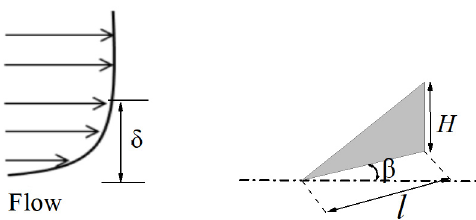
Figure 3. Diagram of VG height ( H ) and boundary layer thickness ( δ ).